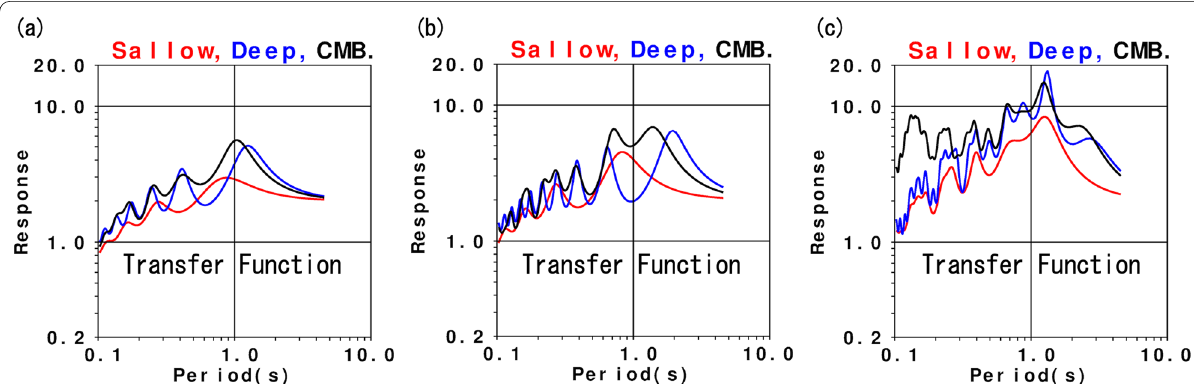
Fig. 5 Calculated site amplifications from simple multi-layer models. a Combined model is a 3 layer model from averaged shallow 4 layers in Fig. 4a as the first layer with two deeper layers down to Vs of 0.67 km/s as indicated in Additional file 1: Table S2a, shallow model is composed from the top two layers of the combined model and the two layers of deep model is composed from averaged shallow two layers of the combined model with basement (Additional file 1: Table S2a). b Same as the panel ( a ) but combined model is composed by changing the second layer to an averaged layer of deeper two layers of combined model in panel ( a ) and adding next deep layer with Vs of 1.267 km/s as the third layer (Additional file 1: Table S2b). c Combined model is total 10 layer model as shown in Fig. 3 and Additional file 1: Table S1, shallow model is a four layer model with a combination of the two combined model in panels ( a ) and ( b ), deep model has two base layers that have Vs of 1.759 km/s as an average of deeper layers and Vs of 3.2 km/s as the seismic bedrock (Additional file 1: Table